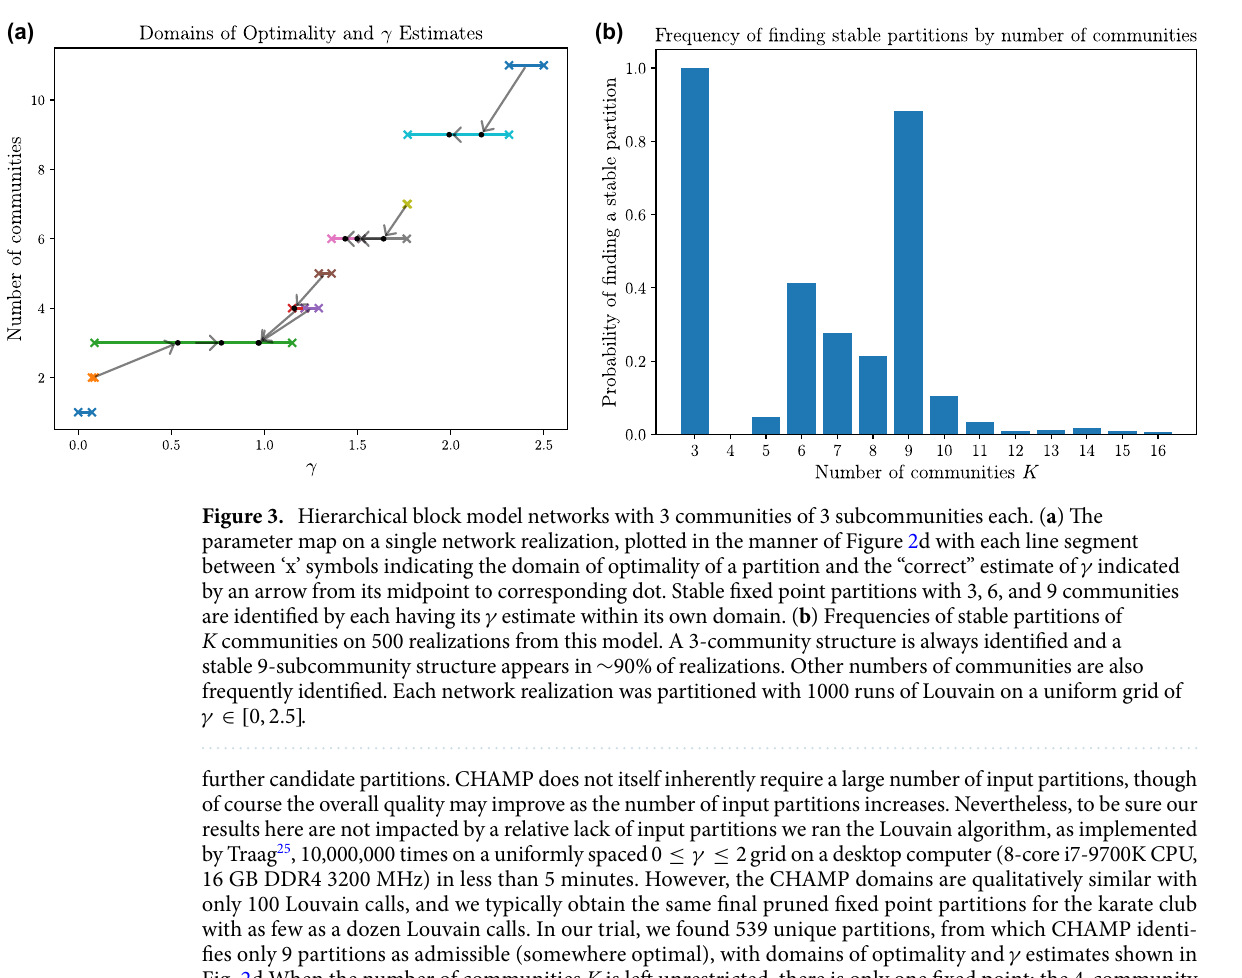
Fig. 2d When the number of communities K is left unrestricted, there is only one fixed point: the 4-community partition in Fig. 2d Note this corresponds to the partition that Pamfil et al.’s iterative procedure most frequently converged to in Fig. 2b On the other hand, when the number of communities is restricted prior to running CHAMP, we find exactly one fixed point for each choice of K ∈ { 2, 3, . . . , 8 } . Given the relatively simple behavior observed in Fig. 2a it is unsurprising that the stable 2-community partition remains the same as that identified using Newman’s procedure. Meanwhile, the 4-community fixed point that was stable for unrestricted K in Fig. 2d is necessarily also a fixed point when we restrict to partitions with K = 4 communities.